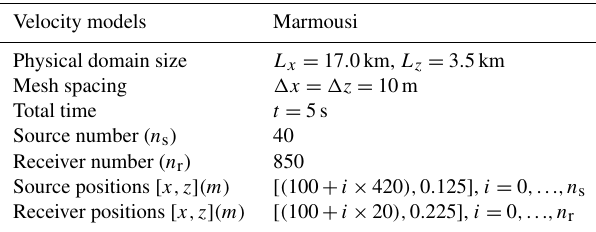
Table 3. Set-up used to carry out the numerical FWI simula- tions, which are used to compute the velocity models that are then matched with Marmousi.